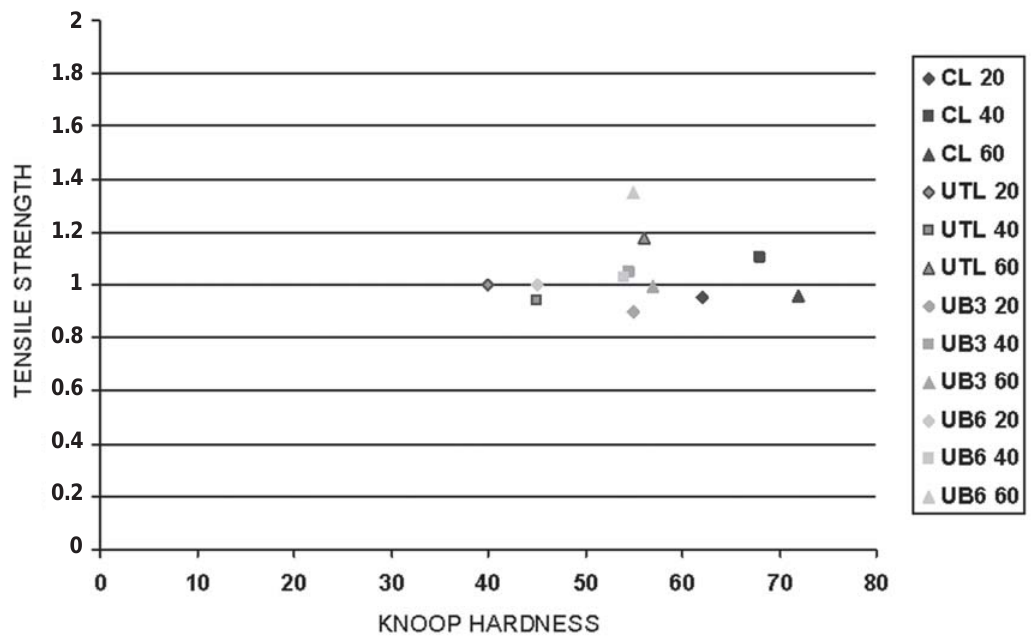
FIGURE 1- Correlation between microhardness (KNH) and tensile strength (MPa) means obtained with the tested